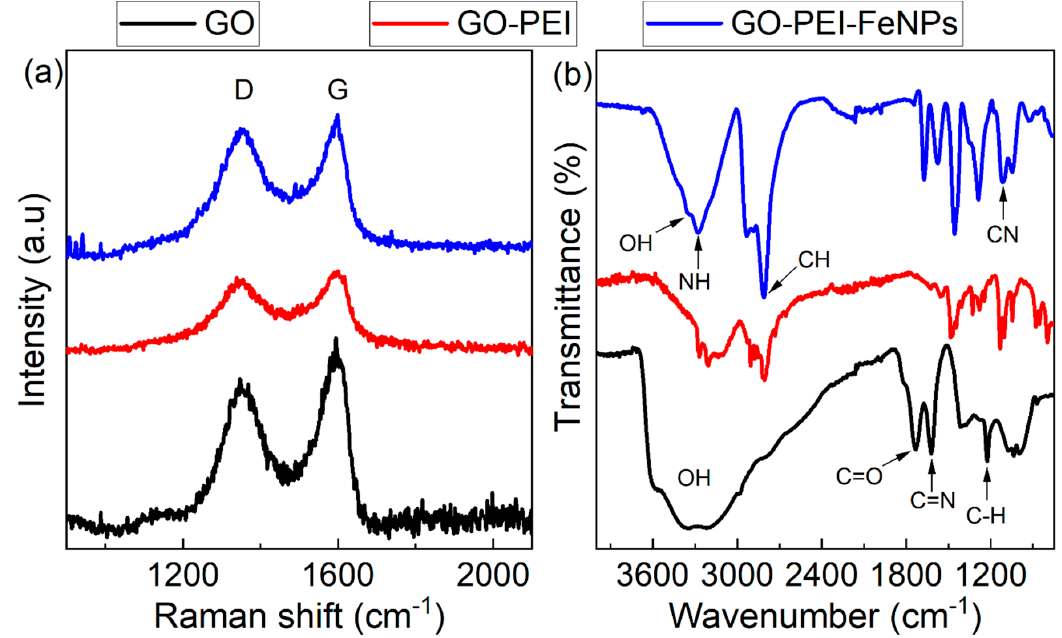
Figure 2. Raman spectra ( a ) and ATR–FTIR ( b ) of GO, GO–PEI and GO–PEI–iron nanoparticles (FeNPs).